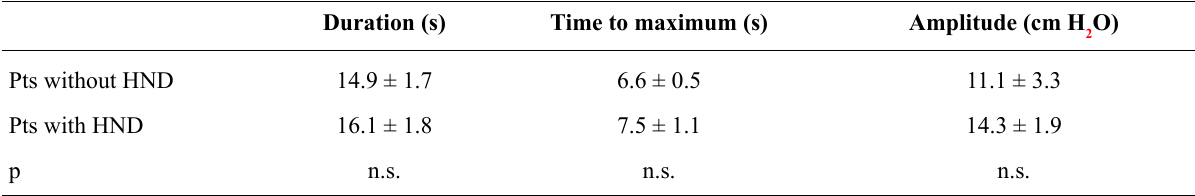
Table 5 - Spatio-temporal characteristics of the successive IDC in the PDO population; comparison between women with or without history of neurological disease (HND).